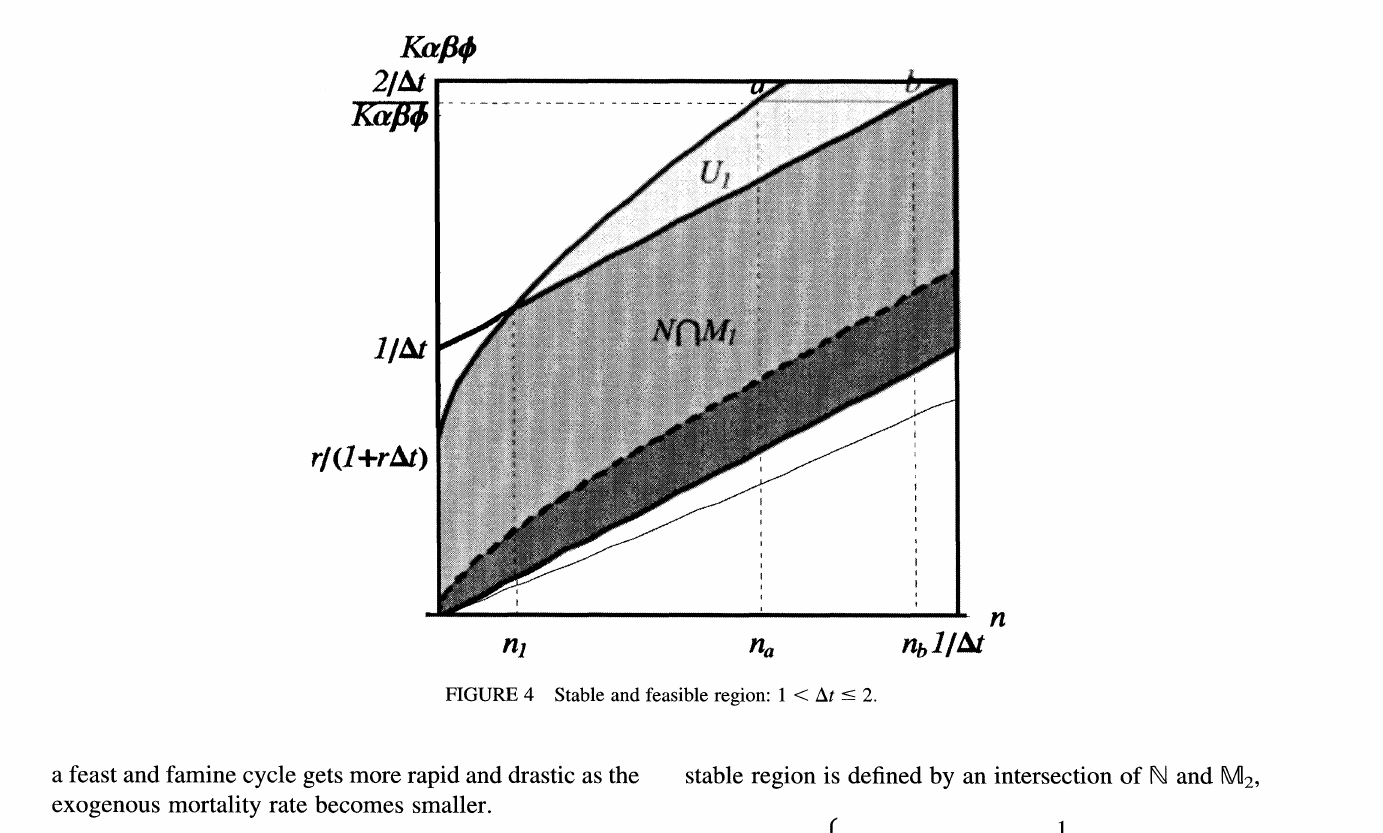
FIGURE 4 Stable and feasible region: < At -< 2.